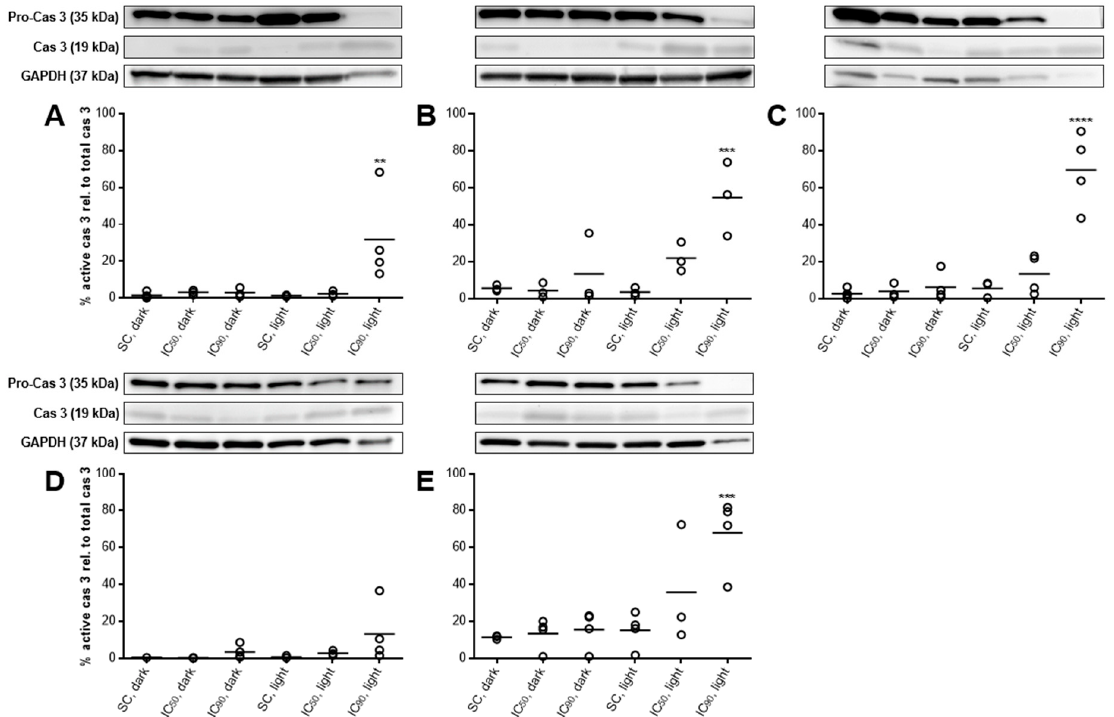
Figure 8. Caspase 3-activation in A-427 ( A ), BHY ( B ), KYSE-70 ( C ), RT-4 ( D ), and SISO ( E ) cells after photodynamic treatment. Cells were treated with either solvent (SC) or equitoxic concentrations (IC 50 or IC 90 in Table 1) of mTHPC between 0.02–0.3 µM, illuminated with 1.8 J/cm 2 or left in the dark, and total protein extracts were harvested 24 h after illumination and western blotting performed. Representative blots are shown and % cas 3 relative to pro-cas 3 was evaluated by densitometric analysis. GAPDH was used as a loading control. Data presented as dot plots from at least three independent experiments. Solvent-treated, non-illuminated cells served as the reference group. ( ** p < 0.01; *** p < 0.001; **** p < 0.0001).